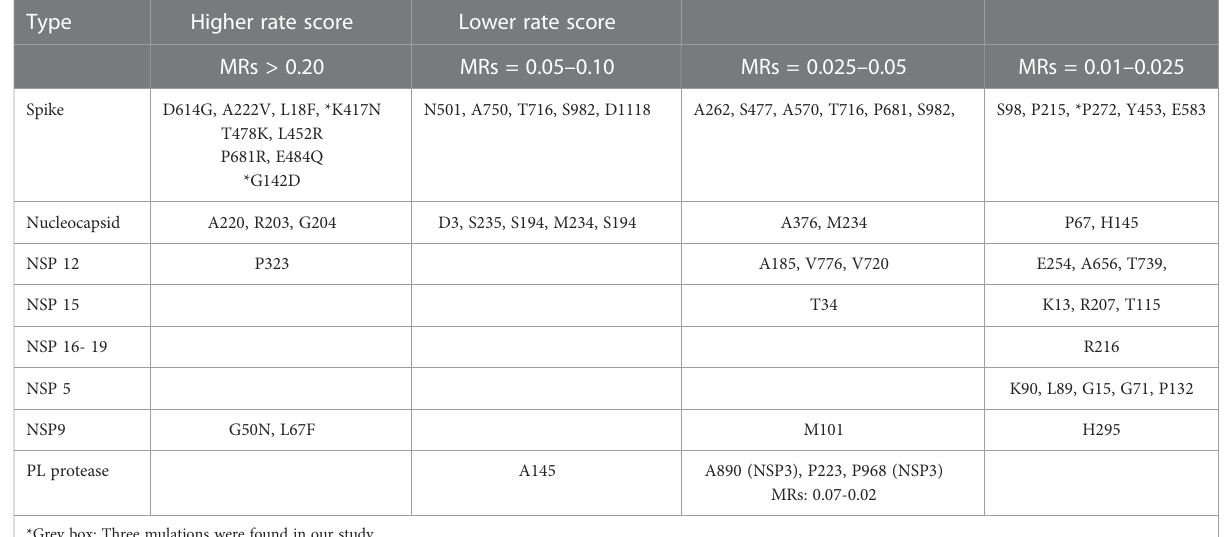
TABLE 3 A summary of residue mutations rates (MRs) of SARS-CoV-2 during the SARS-CoV-2 pandemic according to the report by Vilar and Isom (2021) (1), and https://en.wikipedia.org/wiki/SARS-CoV-2_Omicron_variant. Type